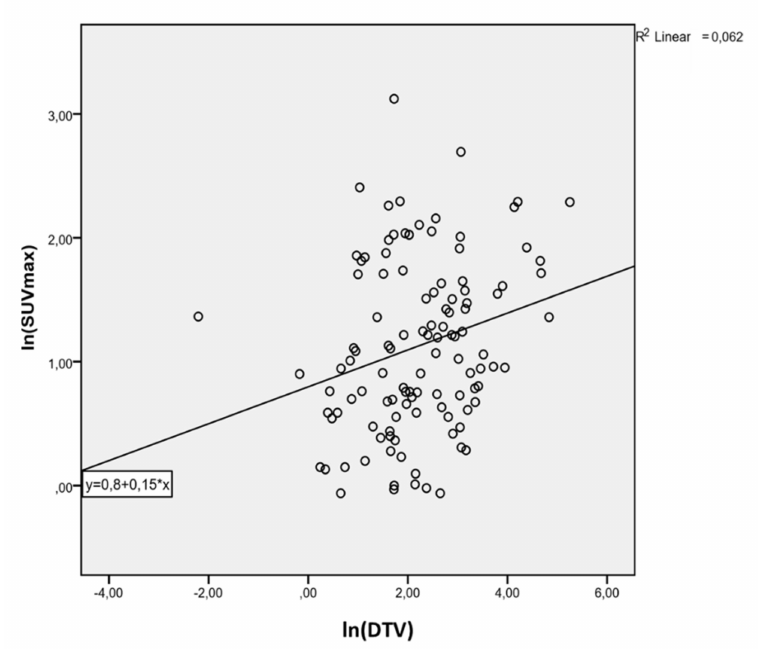
Figure 2. Univariate analysis model of the association between lnSUVmax and